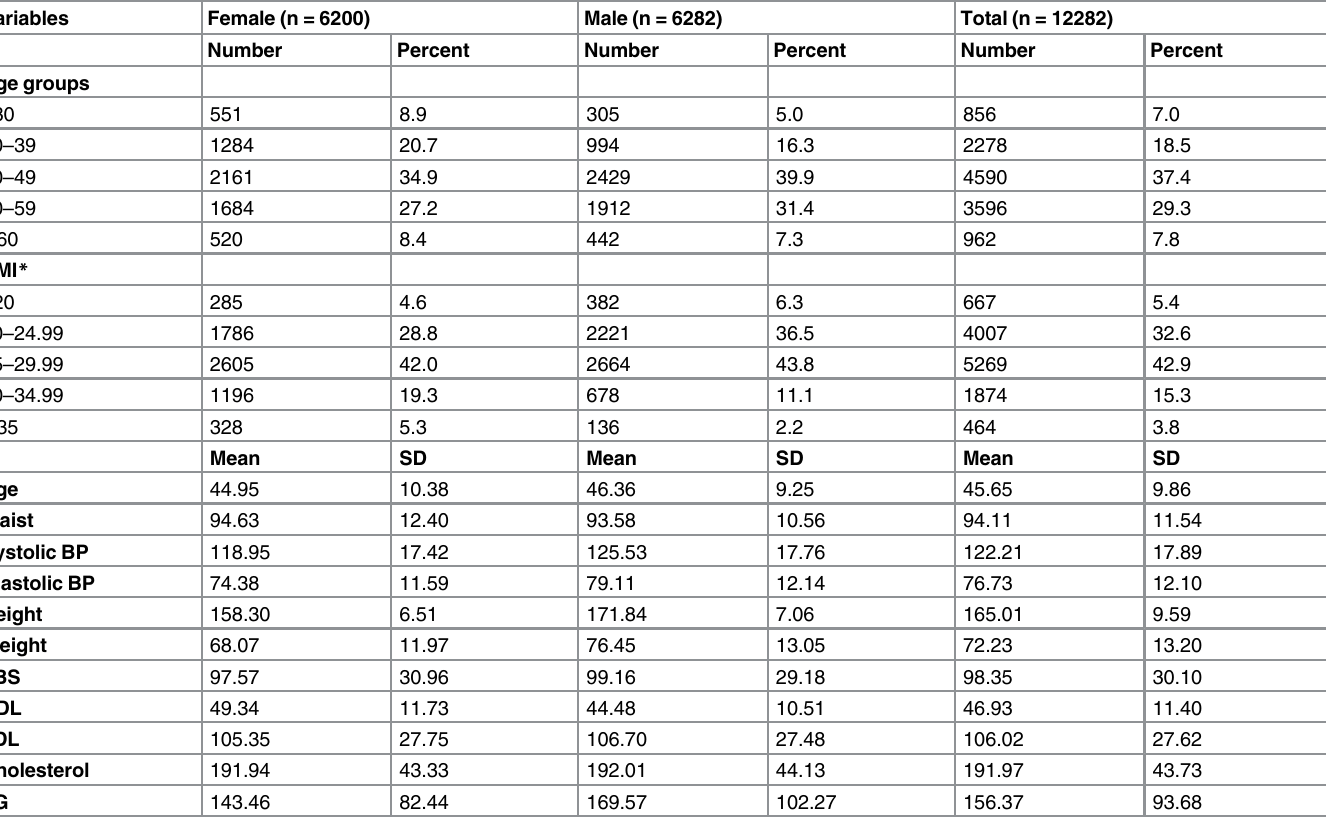
Table 1. Demographic characteristics of the study